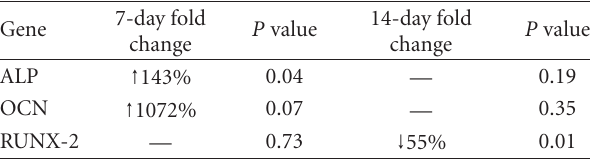
Table 4: Changes in mRNA levels with perfusion flow at 7- and 14-day samples (co-cultures).